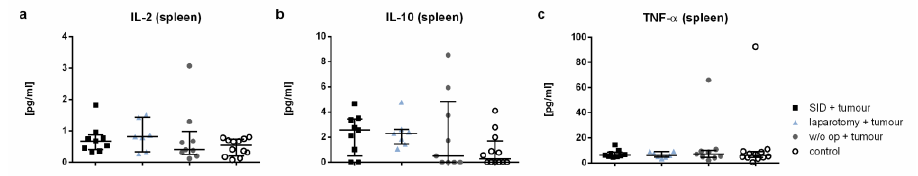
Figure A2. Cytokine levels in plasma. The cytokine levels were measured by CBA in plasma. The graphics show the cytokine concentrations in pg/mL. The cytokine levels of IFN- γ , IL-12p70, IL-13, and IL-21 ( d – g ) were not detectable. Values in ( a ) and ( c – g ) represent the median with interquartile ranges; values in ( b ) the mean and standard error with n = 7–12 animals per group (SID + tumour: n = 9; laparotomy + tumour: 7; w/o op + tumour: 8; control: 12).